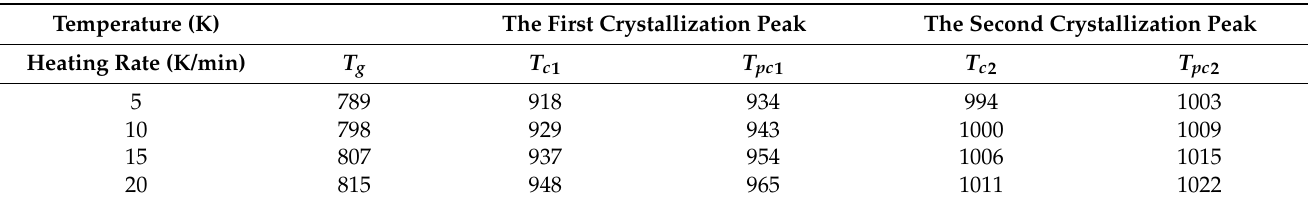
Table 1. Characteristic temperatures measured using non-isothermal differential scanning